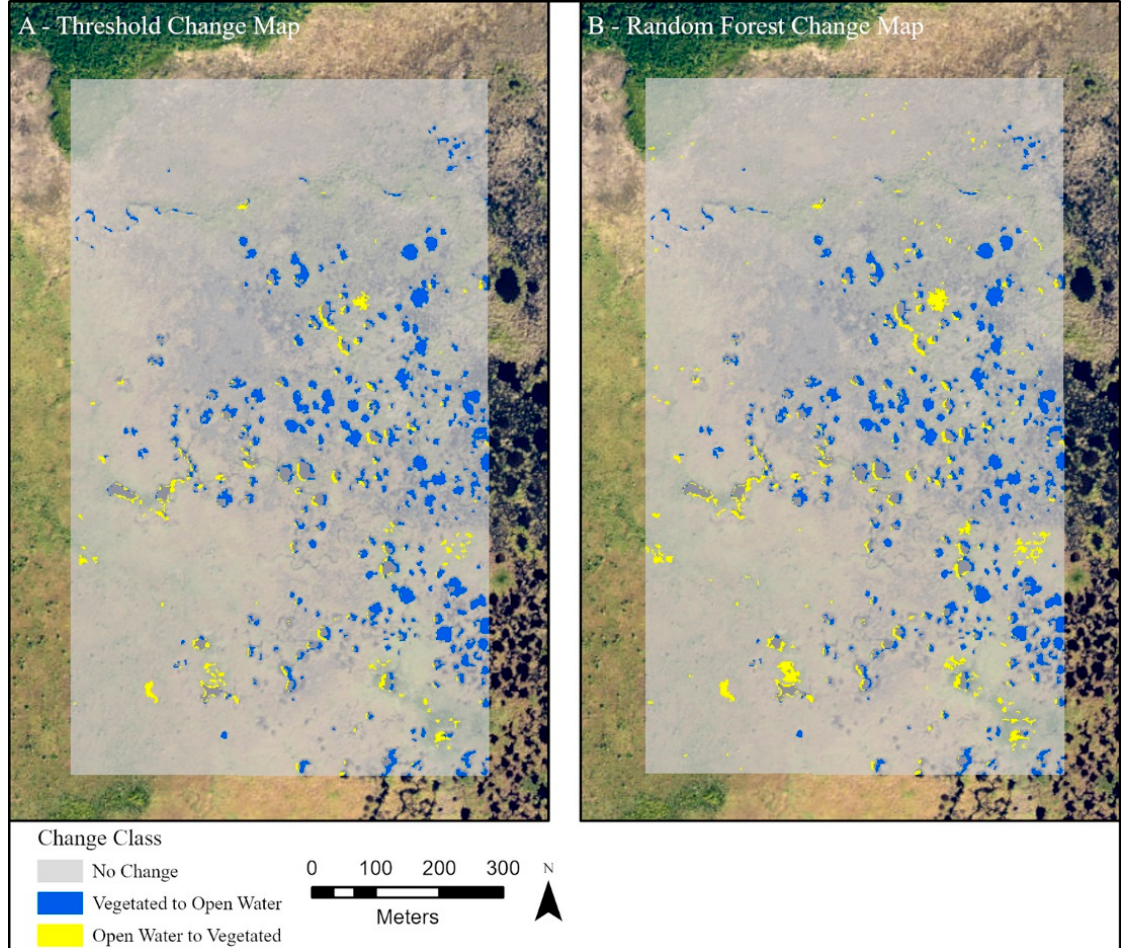
Figure 6. Maps of ( A ) wetland change between the 1940 manual threshold and the 2012 random forest classifications; ( B ) wetland change between the 1940 random forest and 2012 random forest classifications. Both maps are shown at a 12 m 2 MMU. There are three wetland change classes: no change (semitransparent grey), vegetated wetland to open water (blue), and open water to vegetated wetland (yellow).